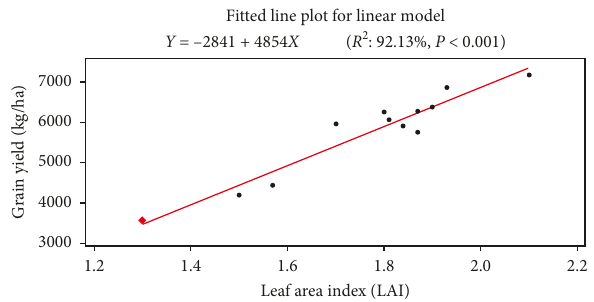
Figure 6: Relationship between grain yield and LAI.